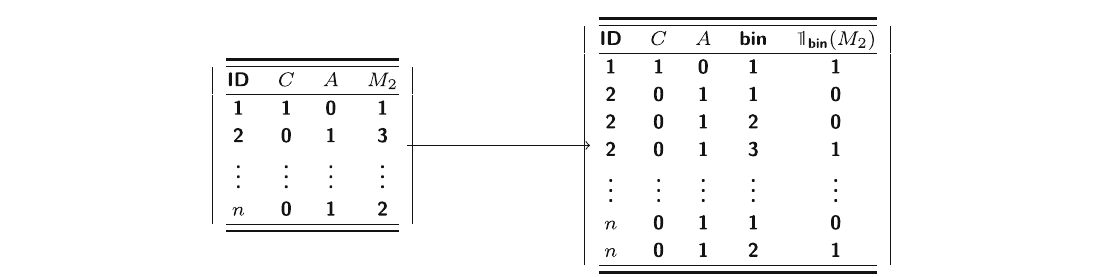
Table 1: An illustration of how to make a long form data set suitable for estimating mediator distributions